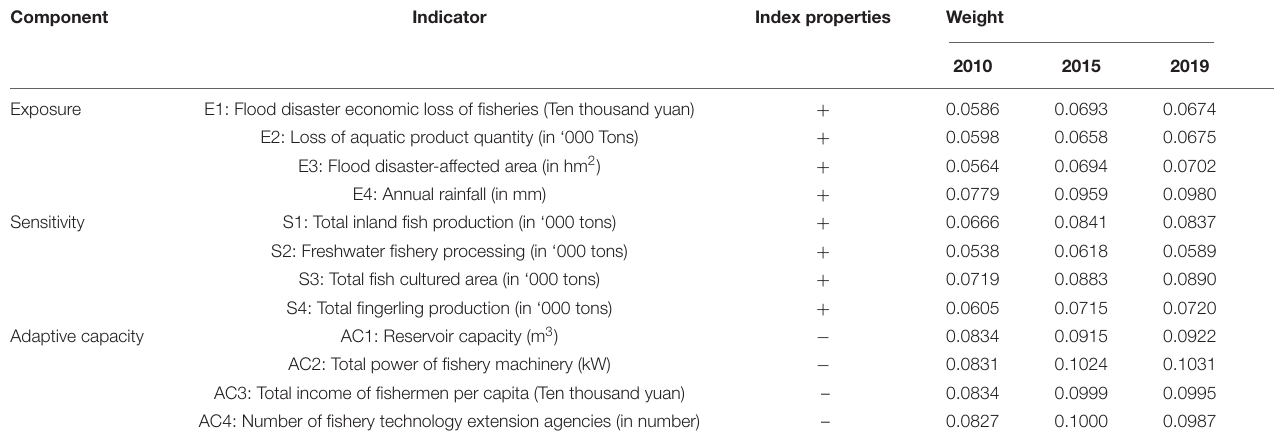
TABLE 1 | Index system of flood vulnerability assessment of inland fisheries in China. Component